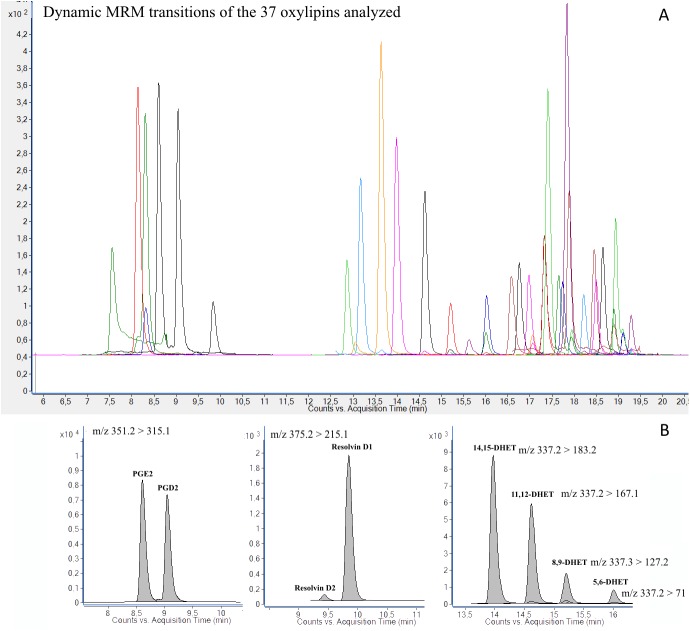
MRM chromatograms of each analyte analyzed in a standard solution mixture (A) and separation of critical pairs of isomers (B).